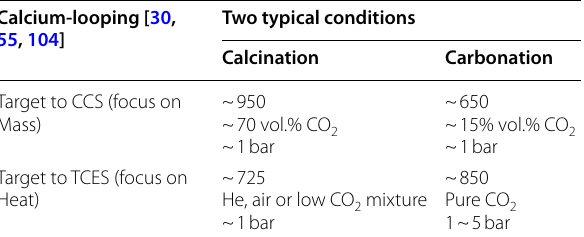
Table 2 Comparison of main typical condition for calcium- looping based CCS and